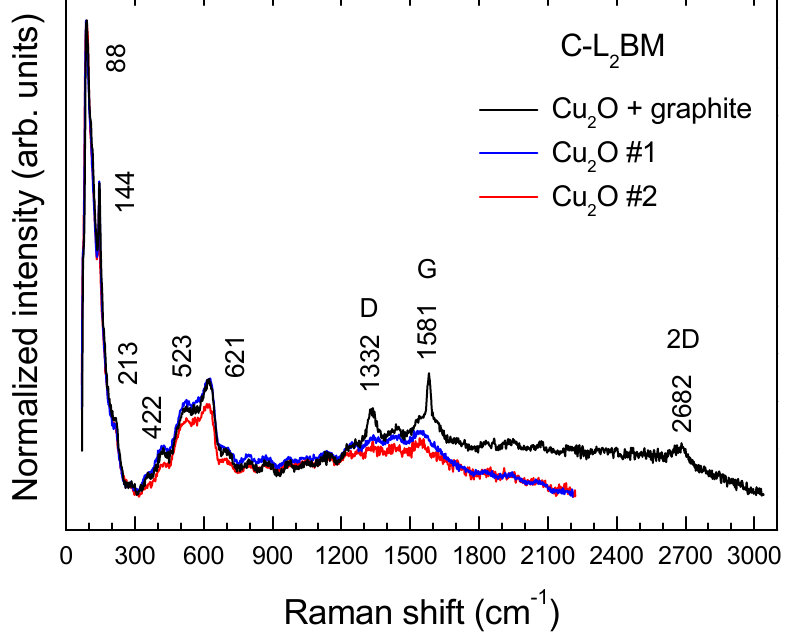
Figure 9. Raman spectra of small Cu 2 O particles from the C-L 2 BM sample.